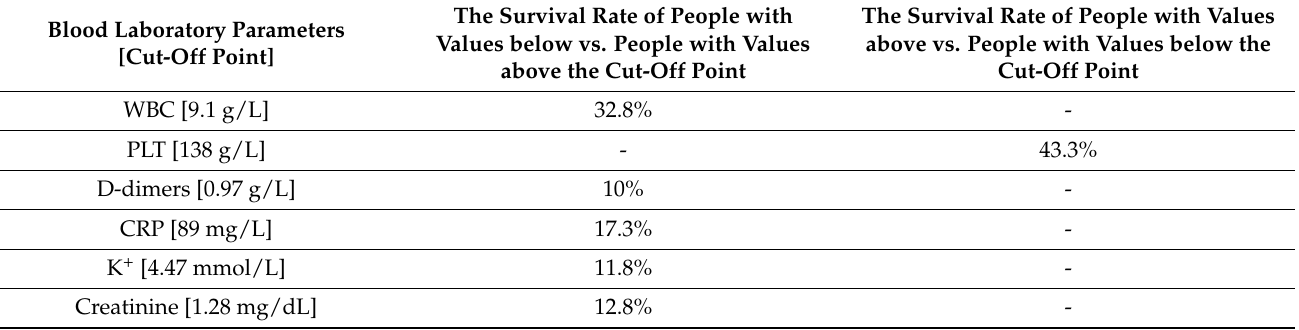
Table 5. Comparison of survival on day 12 of hospitalization for two groups of patients against the cut-off point for individual laboratory parameters.